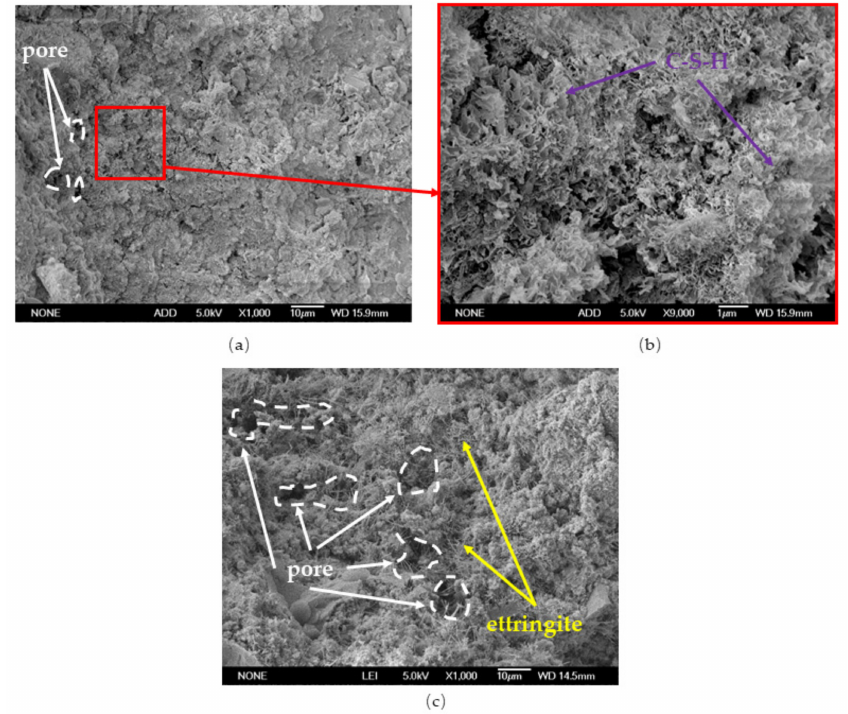
Figure 7. SEM images of MSGB and cement at 28 d curing age. ( a ) MSGB-X1000. ( b ) MSGB-X9000. ( c )